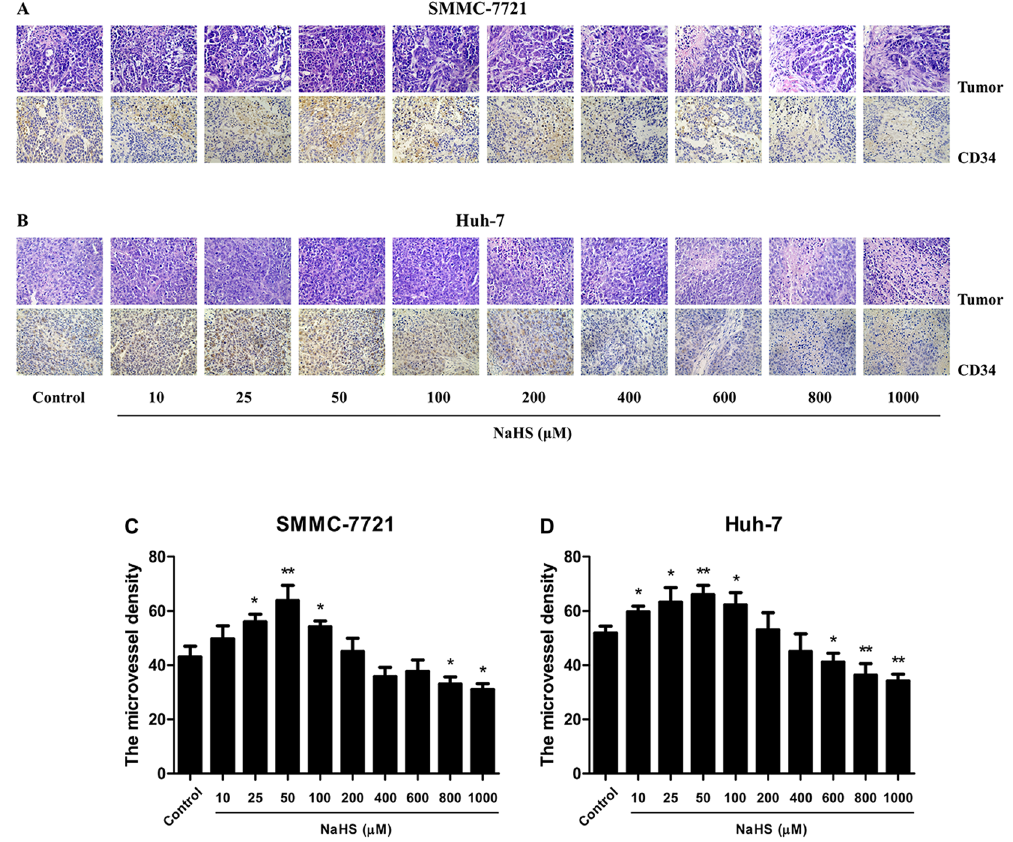
Figure 8. Effect of H 2 S on the angiogenesis of HCC xenografts. ( A and B ) Tumors were harvested and used for HE and CD34 staining; original magnification 400x. ( C and D ) MVD was determined by counting the number of microvessels in HCC xenografts. Values are presented as mean ± SEM (n = 6); * P < 0.05, ** P < 0.01 compared with the control